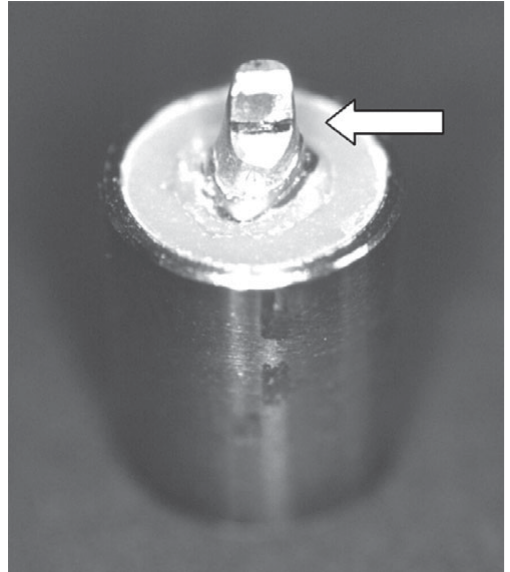
Figure 4 . Specimen clamped inside the steel ring.